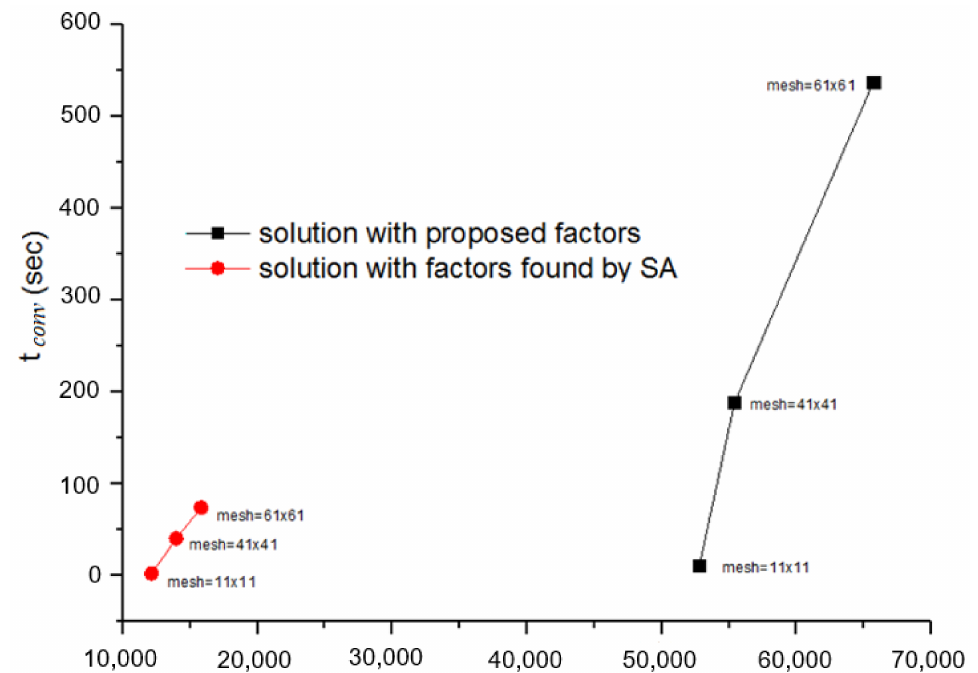
Figure 9. Comparison of t conv with respect to the number of iterations for the solution of the Driven- Cavity problem with different relaxation factors (those proposed and those found with SA).